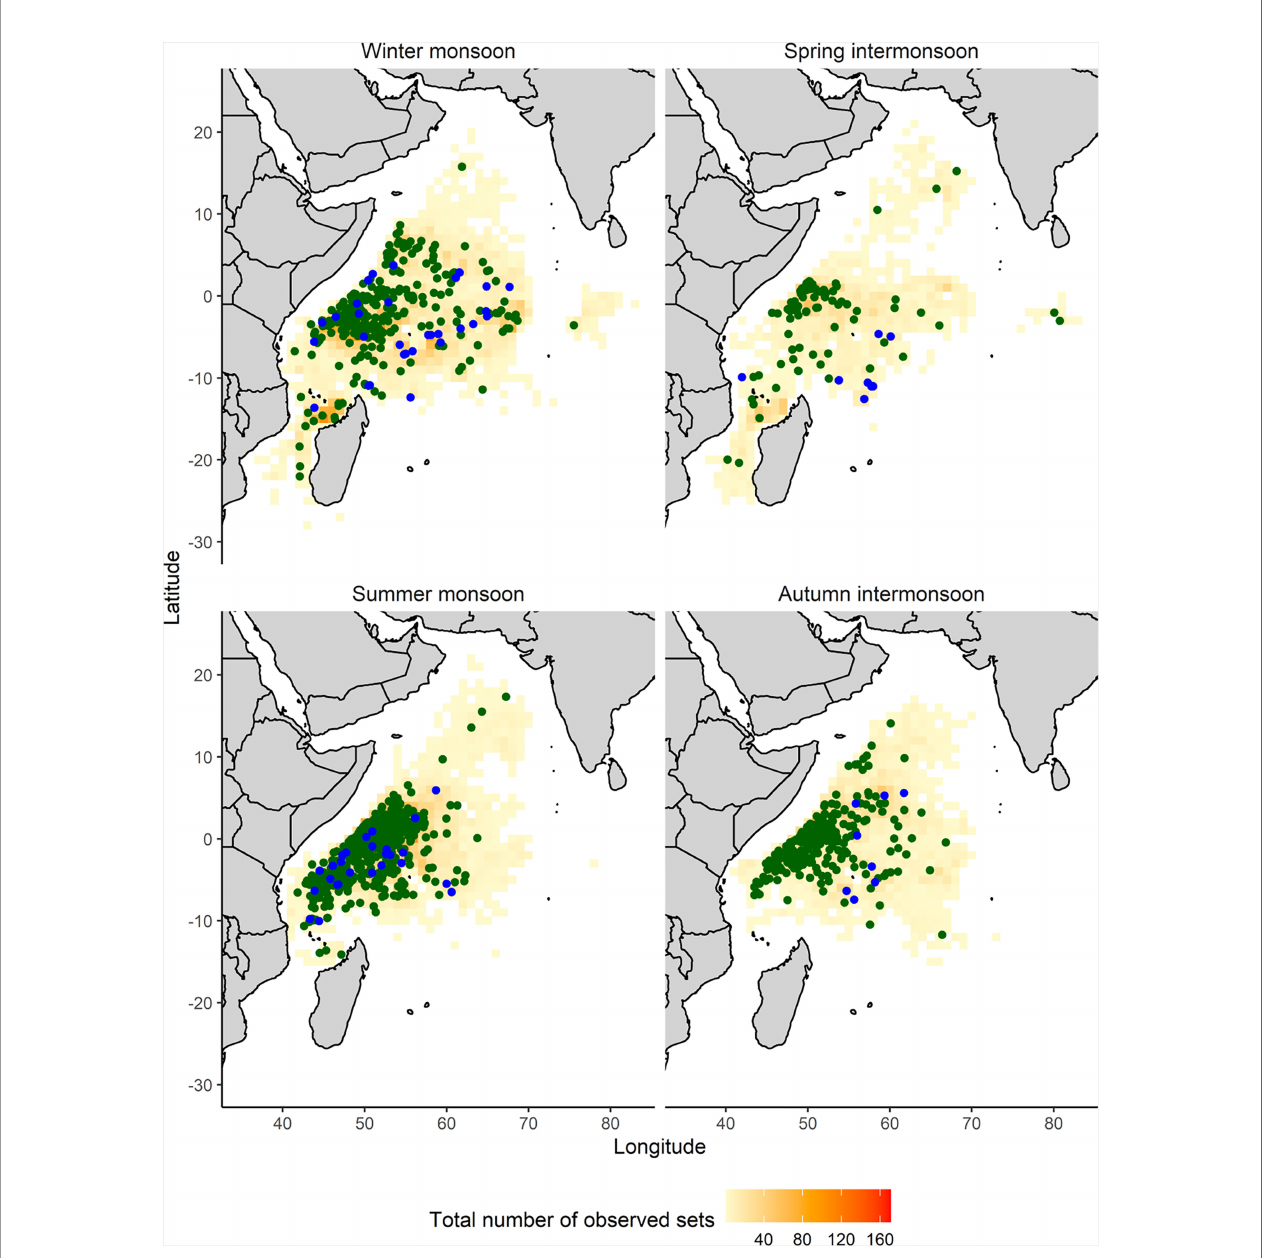
FIGURE 1 | Spatial distribution of cumulative effort (observed sets) in the EU and associated fl ags purse seine fi shery from 2010-2020 and observed presences of oceanic whitetip shark catch by set type (FAD in green dots and FSC in blue dots) by monsoon regimes: winter monsoon (December-March), spring intermonsoon (April and May), summer monsoon (June-September) and autumn intermonsoon (October and November). Check Supplementary Figure 1 for a better appreciation of the cumulative number of observed sets and oceanic whitetip shark catches by set